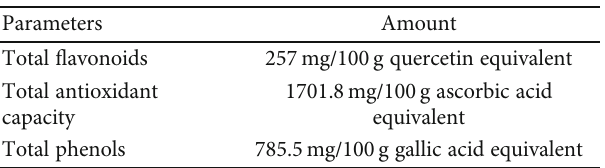
Table 7: Antioxidant composition of Moringa oleifera leaf extract